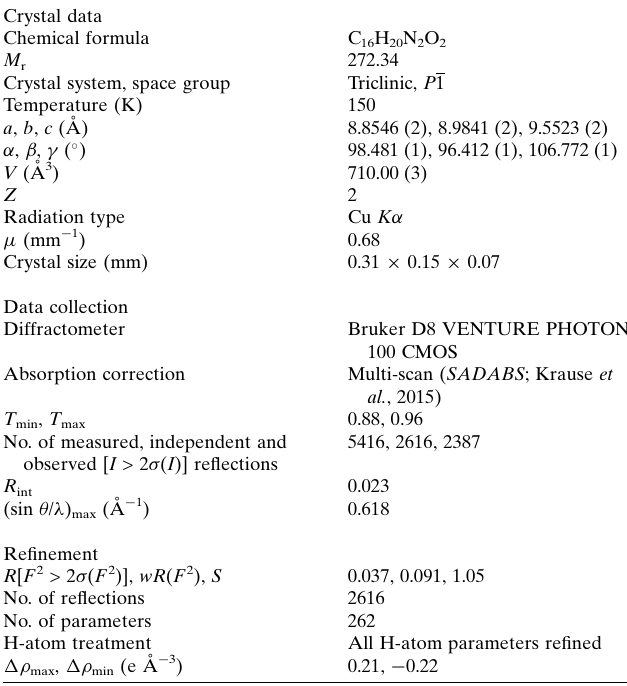
Table 2 Experimental details.